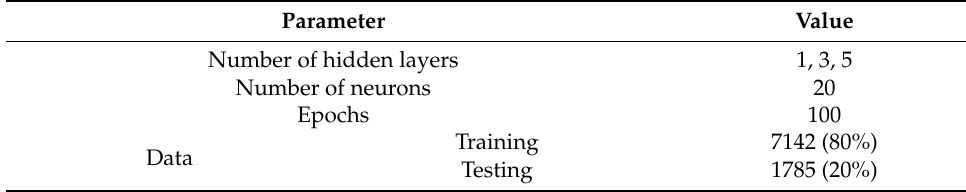
Table 1. Training parameters.